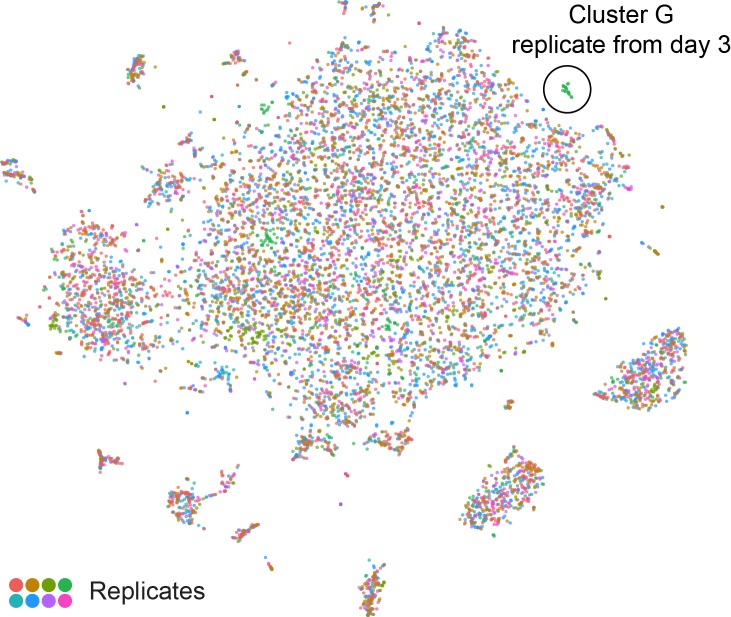
– t-SNE plot showing all eight replicates.t-SNE plot as in Figure 1B, with cells from each replicate in a different color.